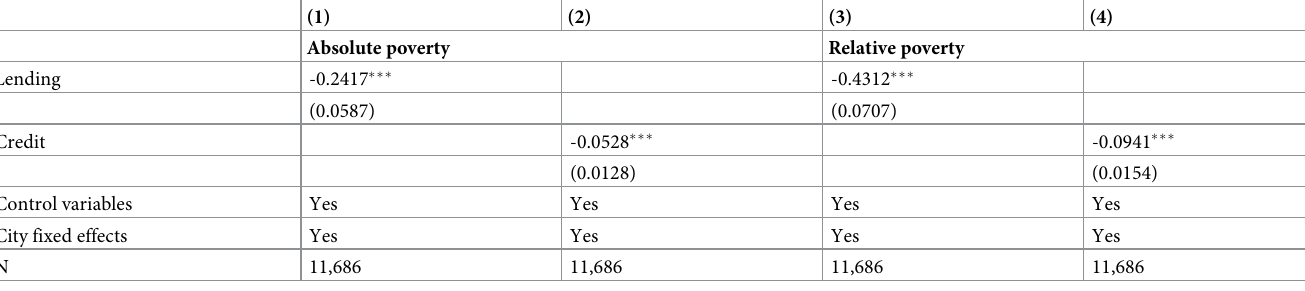
Table 5. Digital financial indicators involving credit and rural household